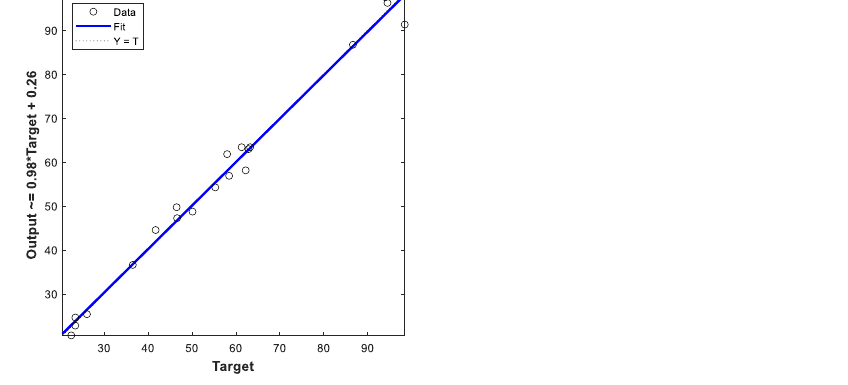
Figure 7. Correlation of actual and predicted values for all data sets by MLR model.